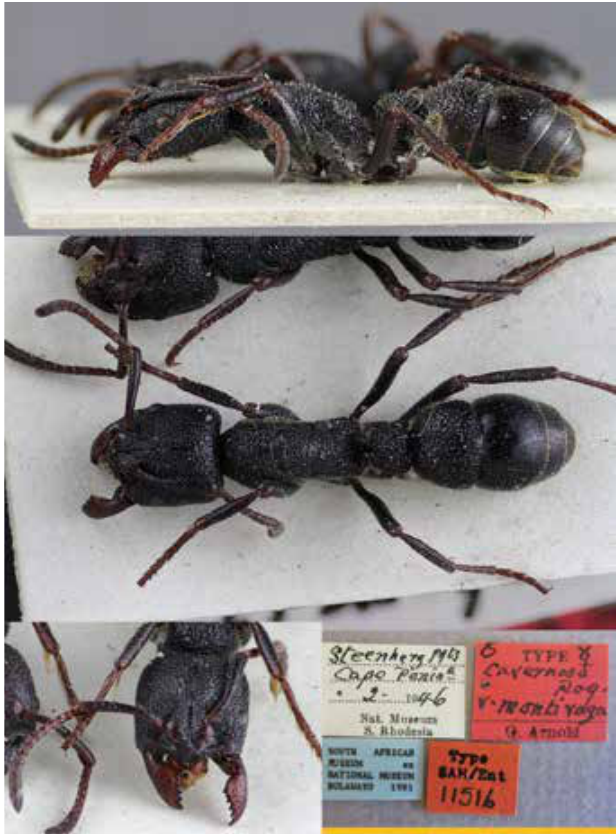
Plate 7 : Bothroponera montivaga , lectotype worker.